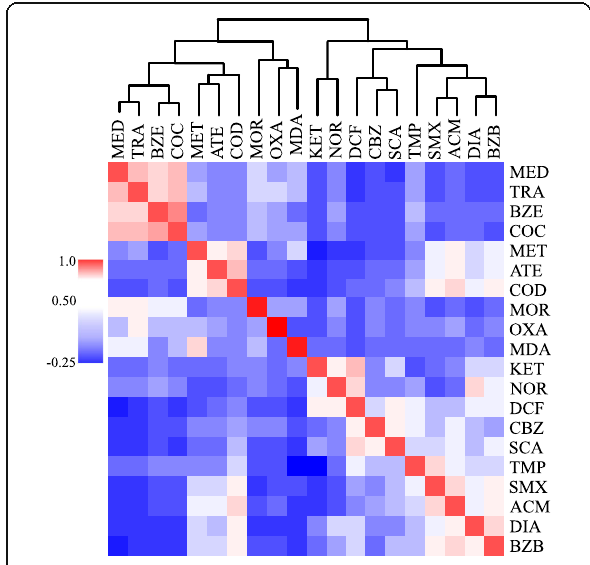
Fig. 5 Heatmap analysis based on the concentrations of each DTR in all samples ( n =